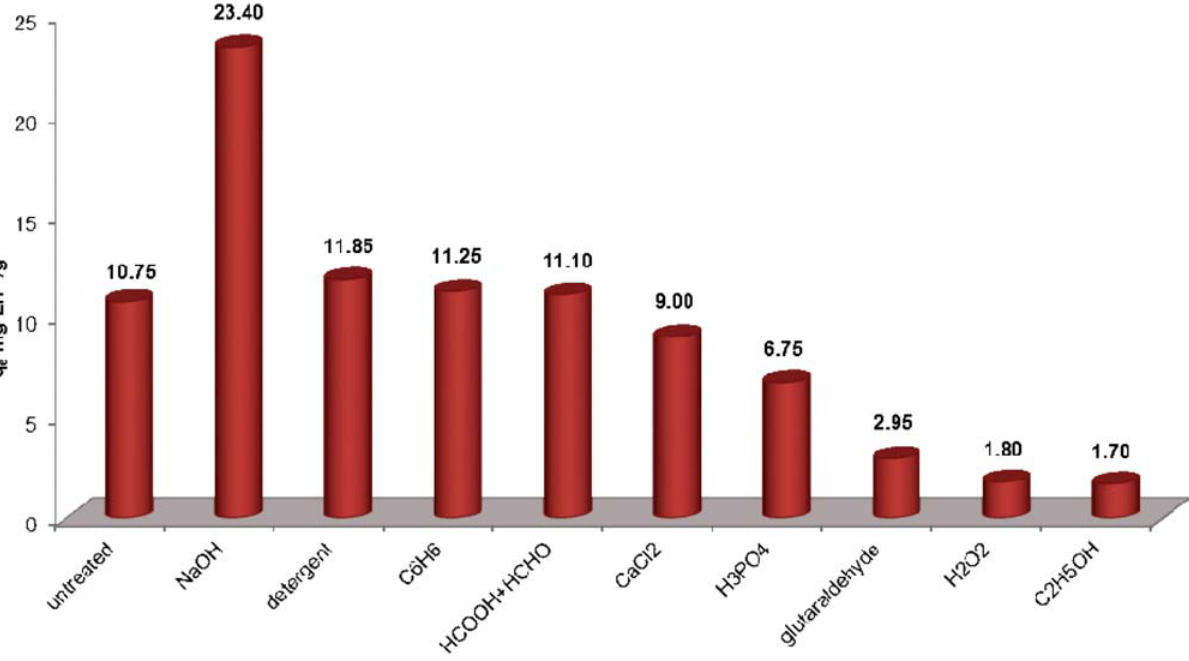
Fig. 4. Effect of different pretreatments on the Zn 2+ uptake of waste brewery yeast biomass; C °C, pH 5.4, 150